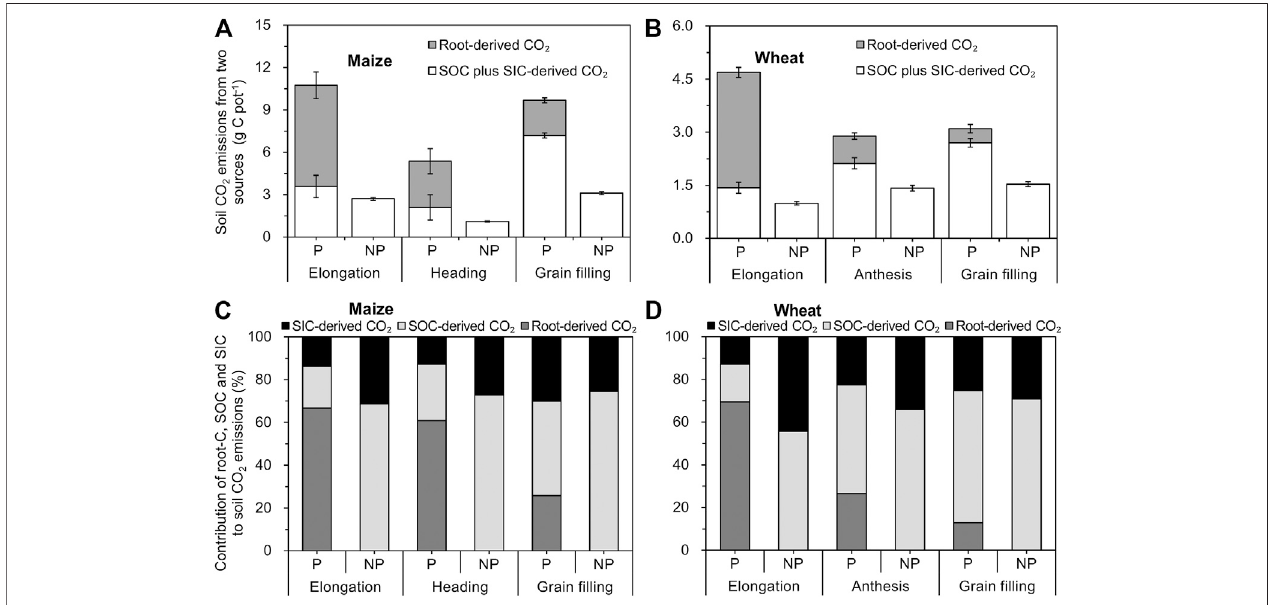
FIGURE 4 | Two-source ( A, B ) and three-source ( C, D ) partitioning of soil CO 2 emissions from the crop-planted soil using 13 C labeling and natural abundance (mean ± SE, n (cid:2) 3 for maize and n (cid:2) 4 for wheat). Note: p and NP represent planted and nonplanted,